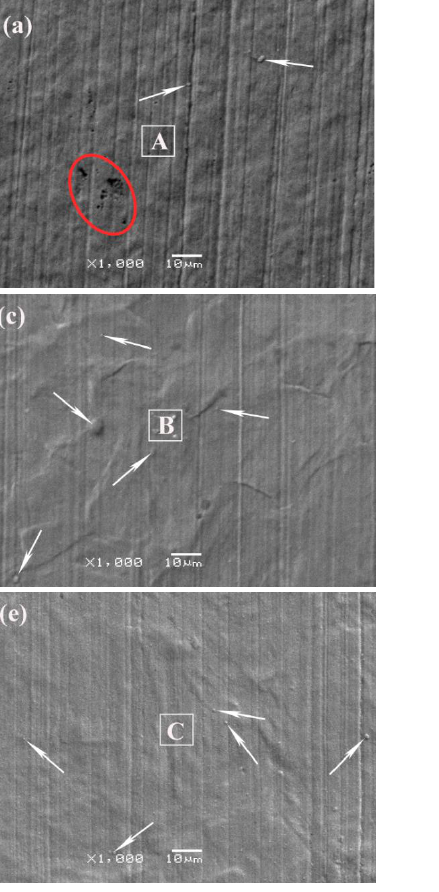
Figure 3. Surface morphology of the nitrided layer on AISI 430 ferritic stainless steel with a different initial microstructure. ( a ) DN450-8, ( b ) EDS result at A, ( c ) SN450-8, ( d ) EDS result at B, ( e ) AN450, and ( f ) EDS result at C. Table 3. Typical element content of an AISI430 ferritic stainless steel surface after nitriding. Element DN450-8 SN450-8 AN450-8 wt.% at.% wt.% at.% wt.% at.% Fe